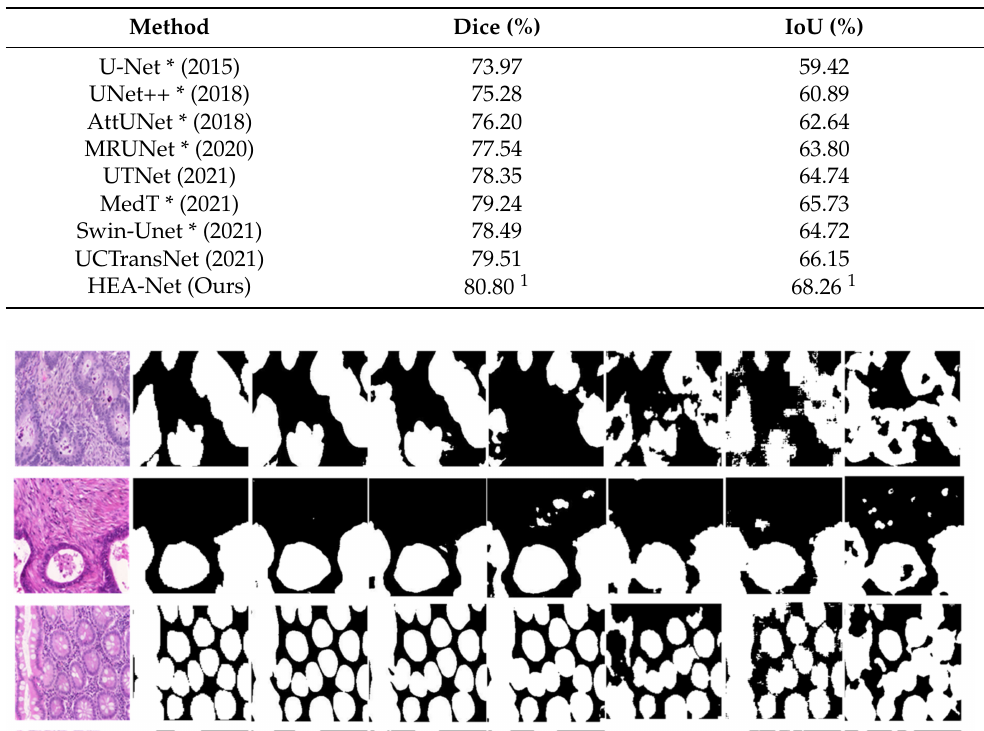
Table 2. Comparative experimental results on MoNuSeg datasets. Network results with “*” are derived from [31]. The superscript “1” indicates the best experimental result.